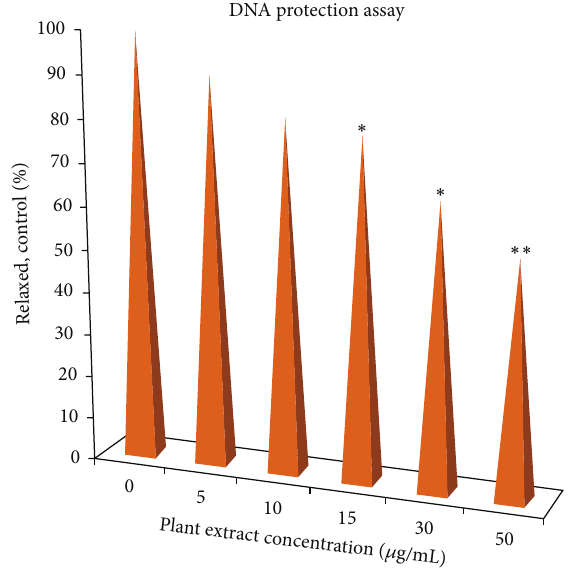
Figure 3: The percentage protection of pUC19 DNA by the extract. Values are expressed as mean of triplicate measurements; ∗ 𝑃 < 0.05 , ∗∗ 𝑃 < 0.01 .